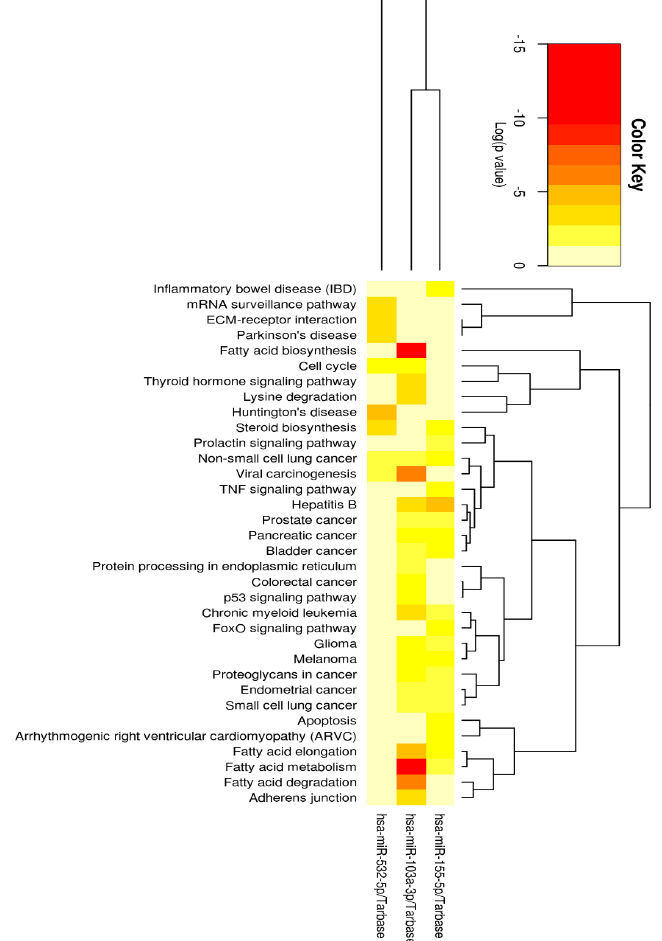
Figure 2. Heatmap of hierarchical clustering of miR-103 , miR-155 and miR-532 based on mRNA target pathways, identified in DIANA using the Tarbase and KEGG pathway union representation. Darker colors represent lower p-values.